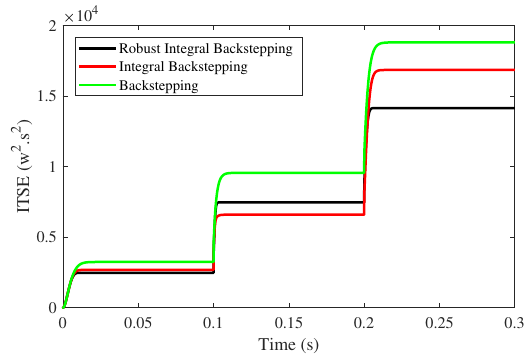
Figure 11. ITSE for varying temperature and irradiance.